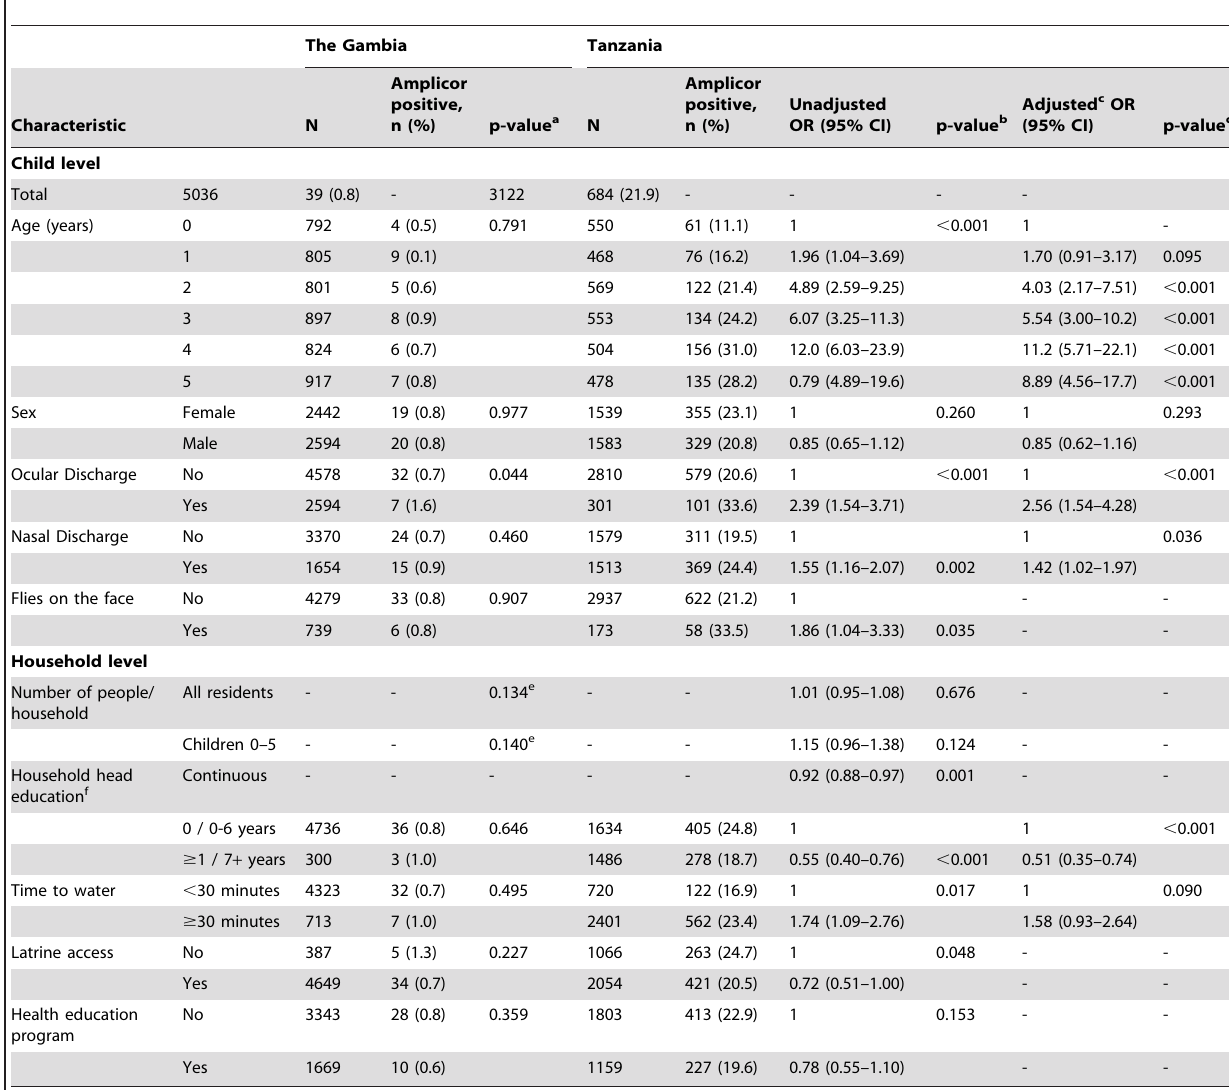
Table 5. Amplicor positive risk factor associations in children aged 0–5 years in The Gambia and